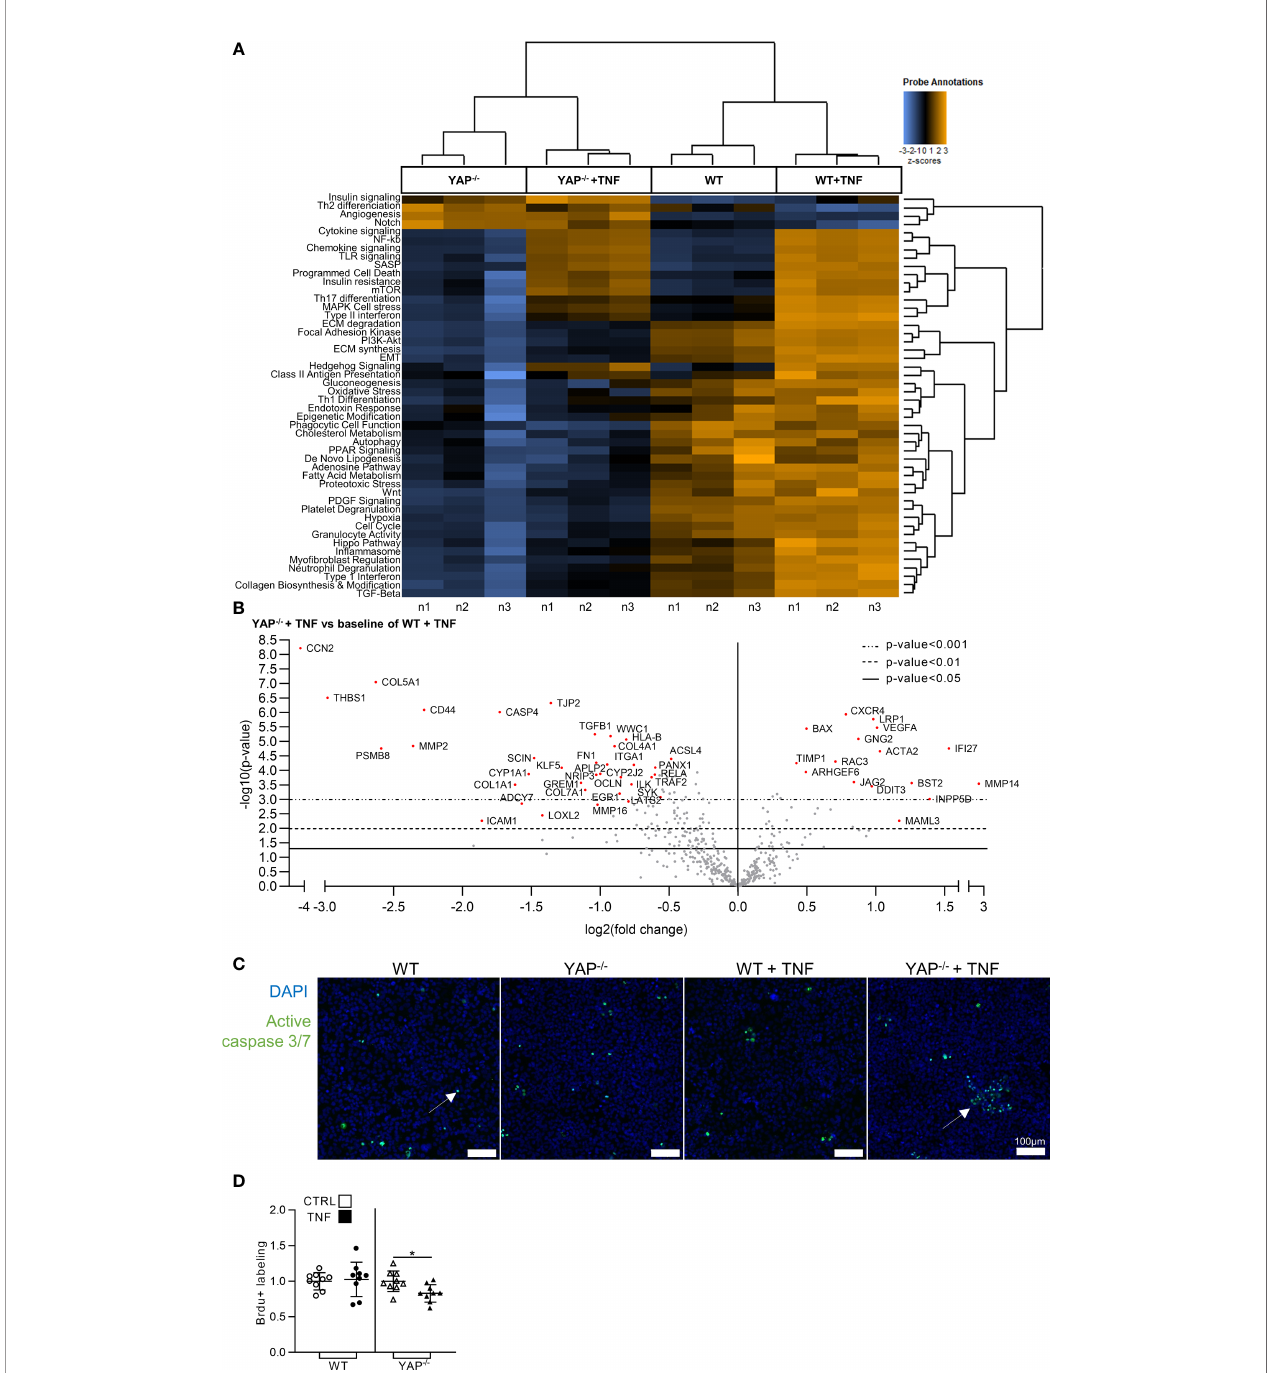
FIGURE 3 | YAP modulates the expression of fi bro-in fl ammatory pathways and promotes cell survival under TNF administration. HEK293 cells were cultured and treated with TNF as described in Figure 1 . (A) Heat map of nanostring fi brosis panel pathways; pathways are listed to the left, the most upregulated pathways are depicted in orange, and the most downregulated pathways in blue; each column corresponded to one sample (n = 3/group). (B) Volcano plot representation for differential genes expression in YAP − / − + TNF group versus the baseline of WT + TNF group; depicted genes were the most differentially expressed with the combination of a low p-value and a high fold change. (C) Representative live confocal images of active caspase 3/7 labeling (green) and DAPI (nucleus, blue). (D) BrdU assay results; results are representative of three independent experiments with 3 biological replicates for each experiment (n = 9 per group) and are represented as single values with mean ± SD and expressed as fold change vs WT control cells or YAP − / − control cells; comparisons were only performed between CTRL and TNF treated cells, t-test *p < 0.05. For caspase labeling, images are representative of 3 independent